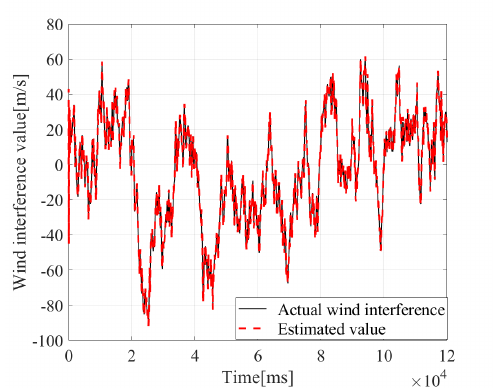
Fig. 8. Wind disturbance estimation in the horizontal